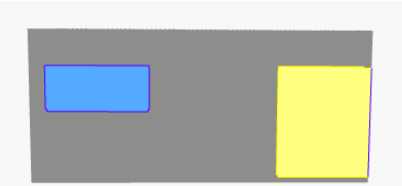
Figure 1. One outer wall surface with two openings, where one opening is a hole (blue) and one opening is aligned to the edge of the wall surface